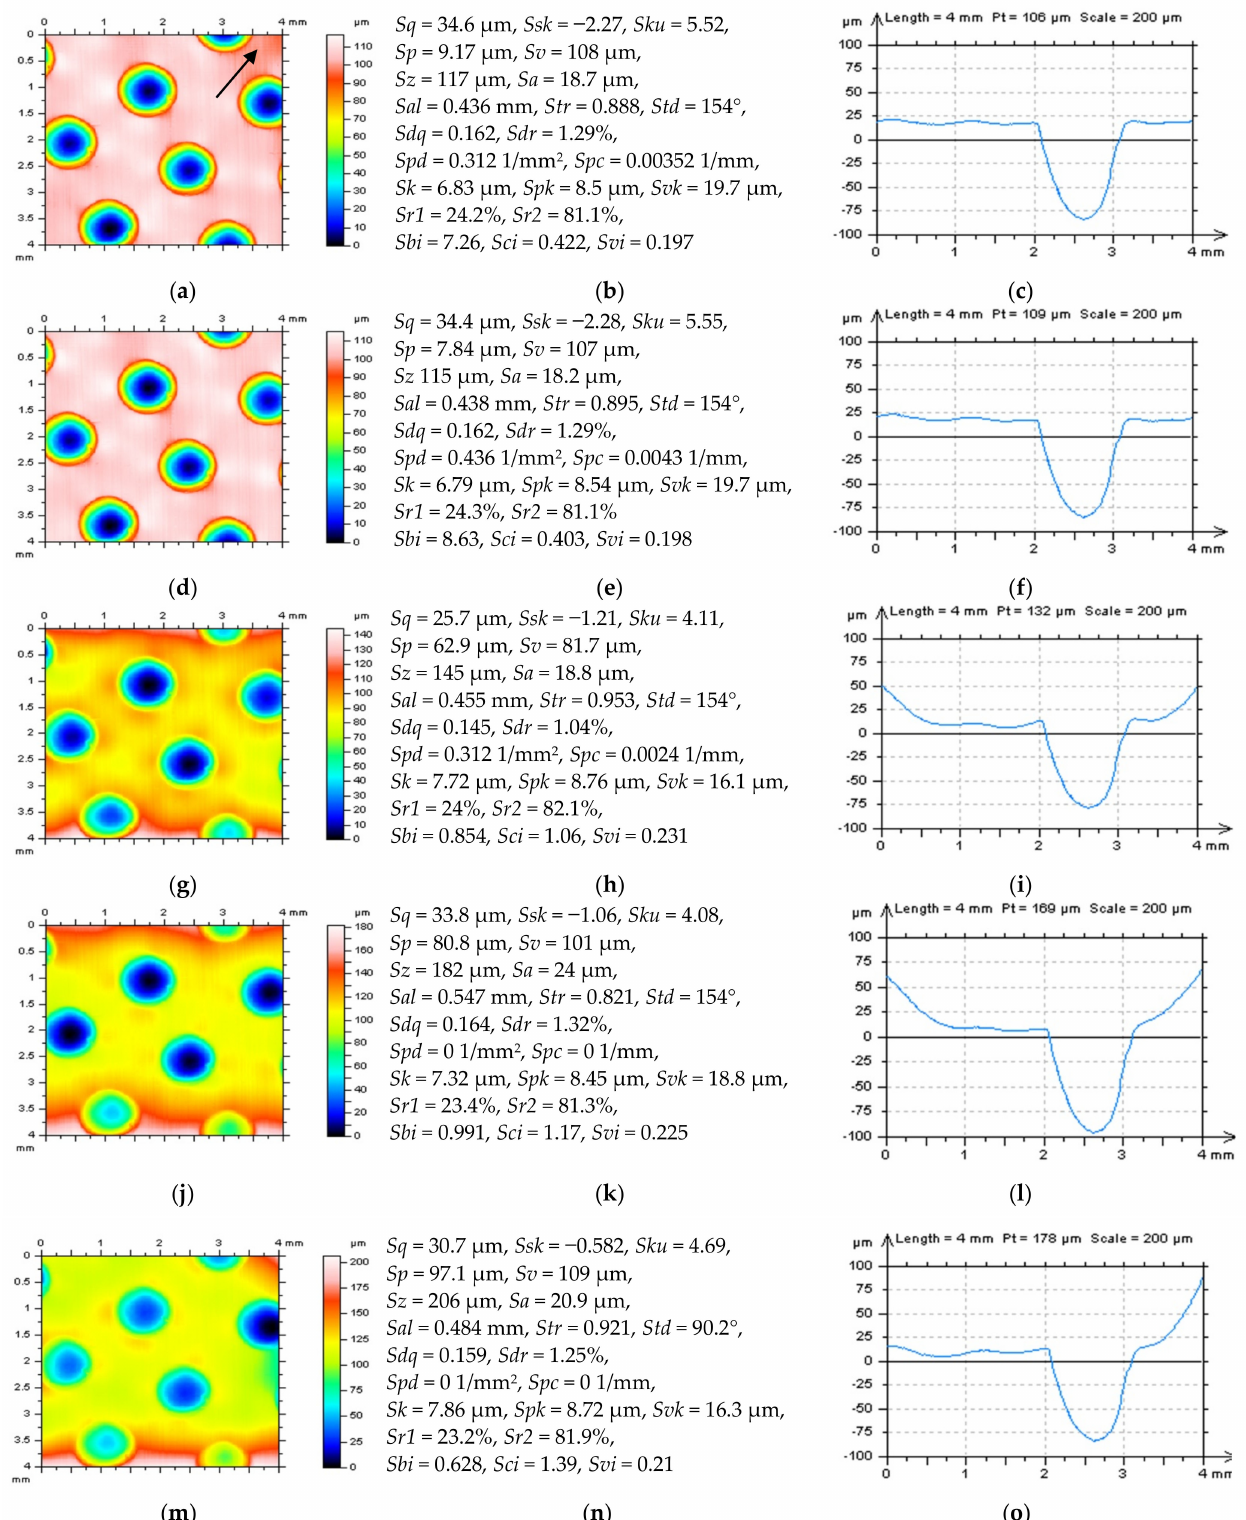
Figure 5. L-surfaces (left column), their ISO 25178 parameters (middle), and selected profiles (right column) received after the application of LSFC ( a – c ) and POLY2 ( d – f ) with VEM, GRF ( g – i ), RGRF ( j – l ), and SF ( m – o ) with a cutoff = 2.5